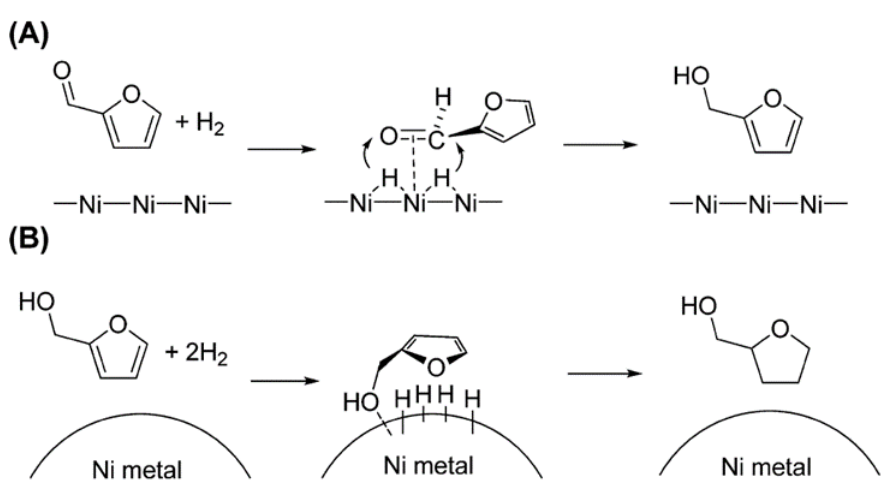
Figure 7. Proposed mechanisms for the hydrogenation of ( A ) furfural and ( B ) FOL over Ni/SiO 2